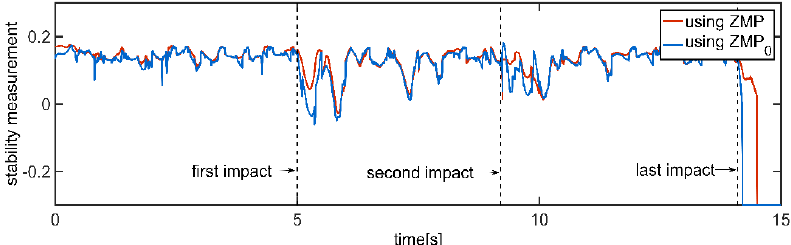
Figure 28. Stability measurements using ZMP and ZMP 0 .